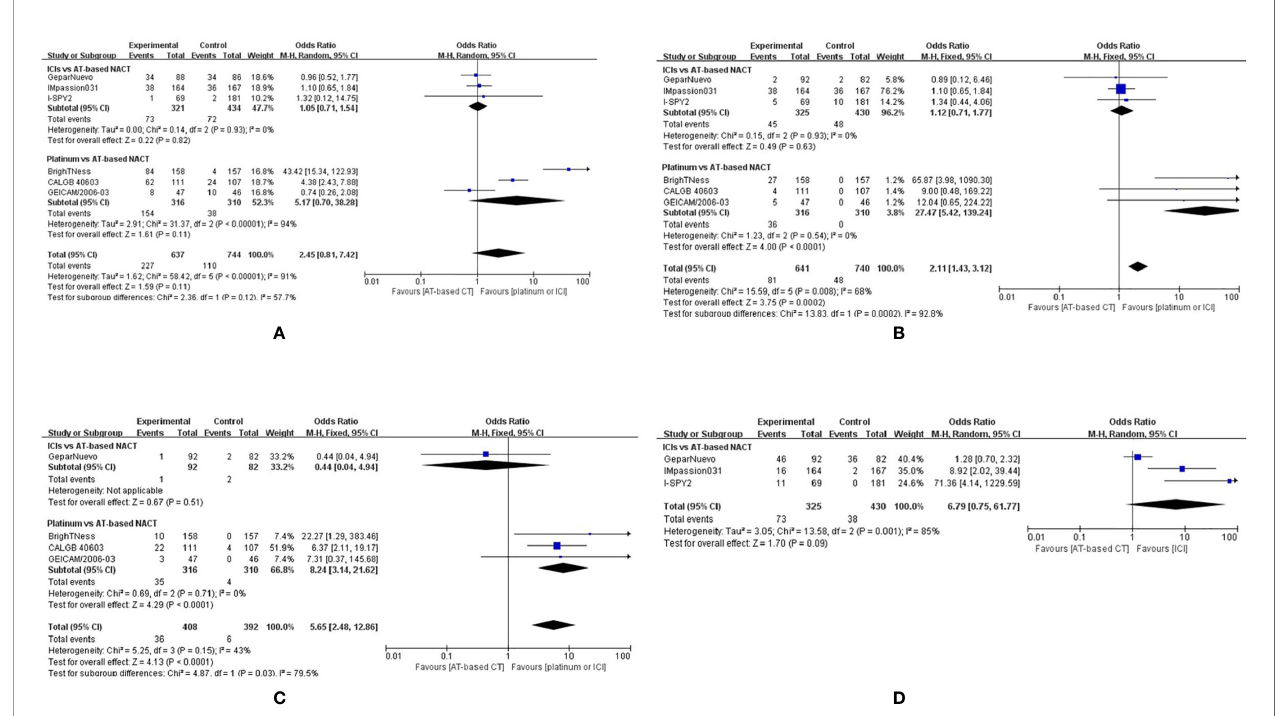
FIGURE 9 | Forest plot showing pooled incidence of grade 3 – 4 neutropenia (A) , anemia (B) , thrombocytopenia (C) in patients receiving ICIs vs AT-based NACT and platinum-based vs AT-based NACT in early TNBC patients, all grades of thyroid dysfunction (D) in patients receiving ICIs vs AT-based NACT.